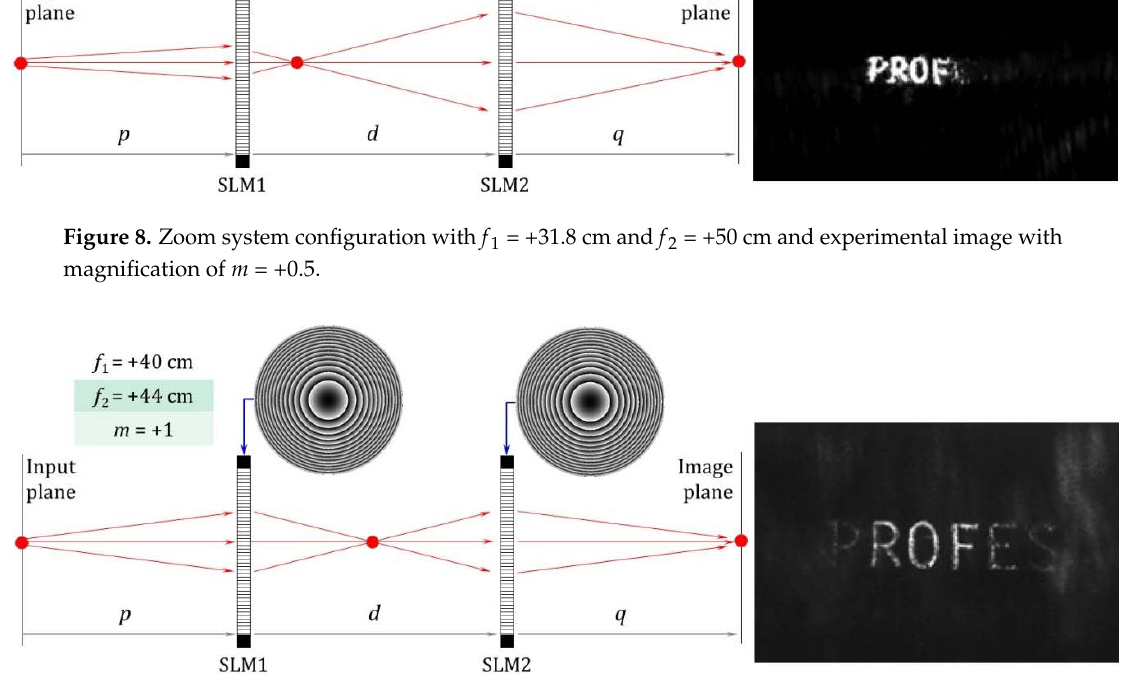
Figure 9. Zoom system configuration with f 1 = +40 cm and f 2 = +44 cm and experimental image with magnification of m = +1.